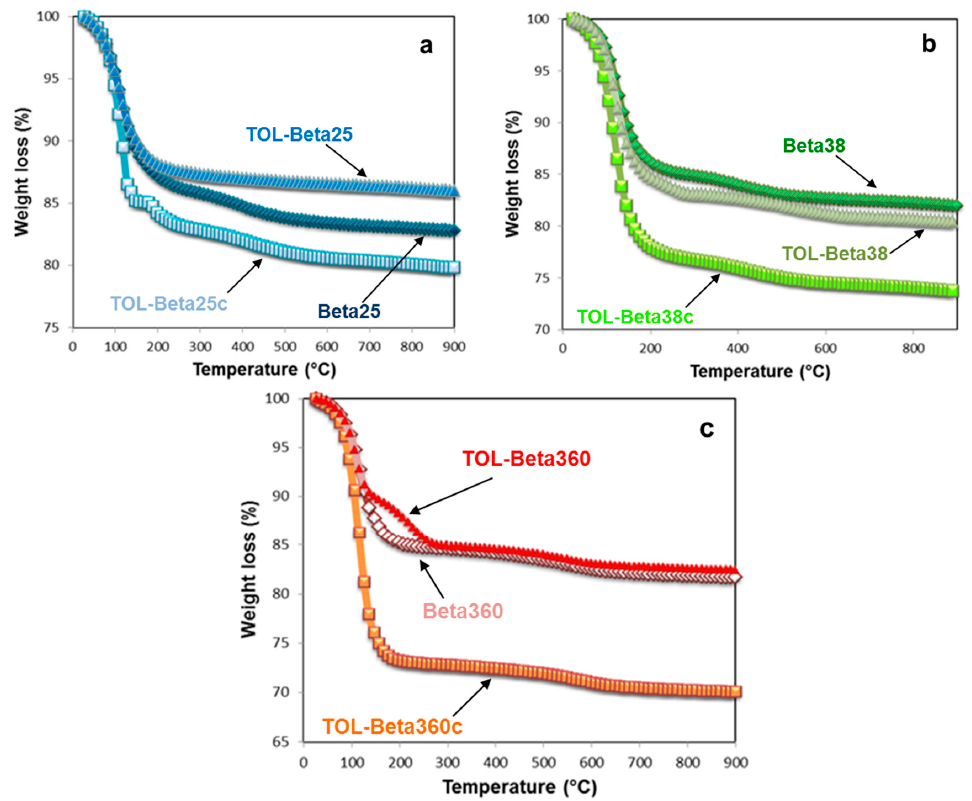
Figure 3. Thermogravimetric curves of as-received and calcined BEAs, before and after saturation with TOL: ( a ) Beta25; ( b ) Beta38; and ( c ) Beta360.